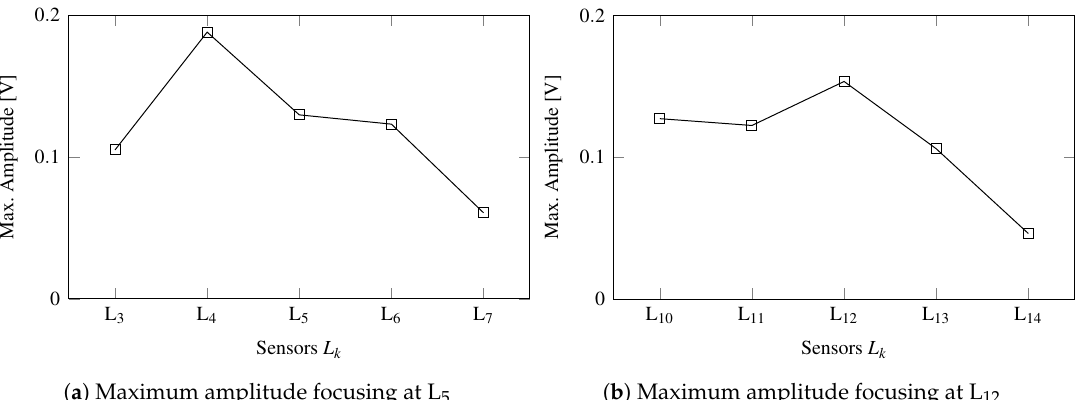
Figure 10. Focusing effect at the edge of the aluminum plate when focusing at sensor L 5 in panel ( a ) and at sensor L 12 placed in the corner of the aluminum plate in panel ( b